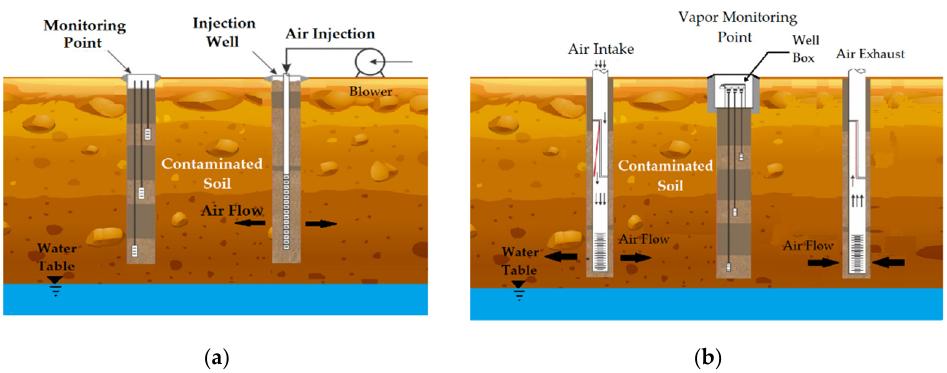
Figure 9. Scheme of bioventing process: ( a ) active technology and ( b ) passive technology.